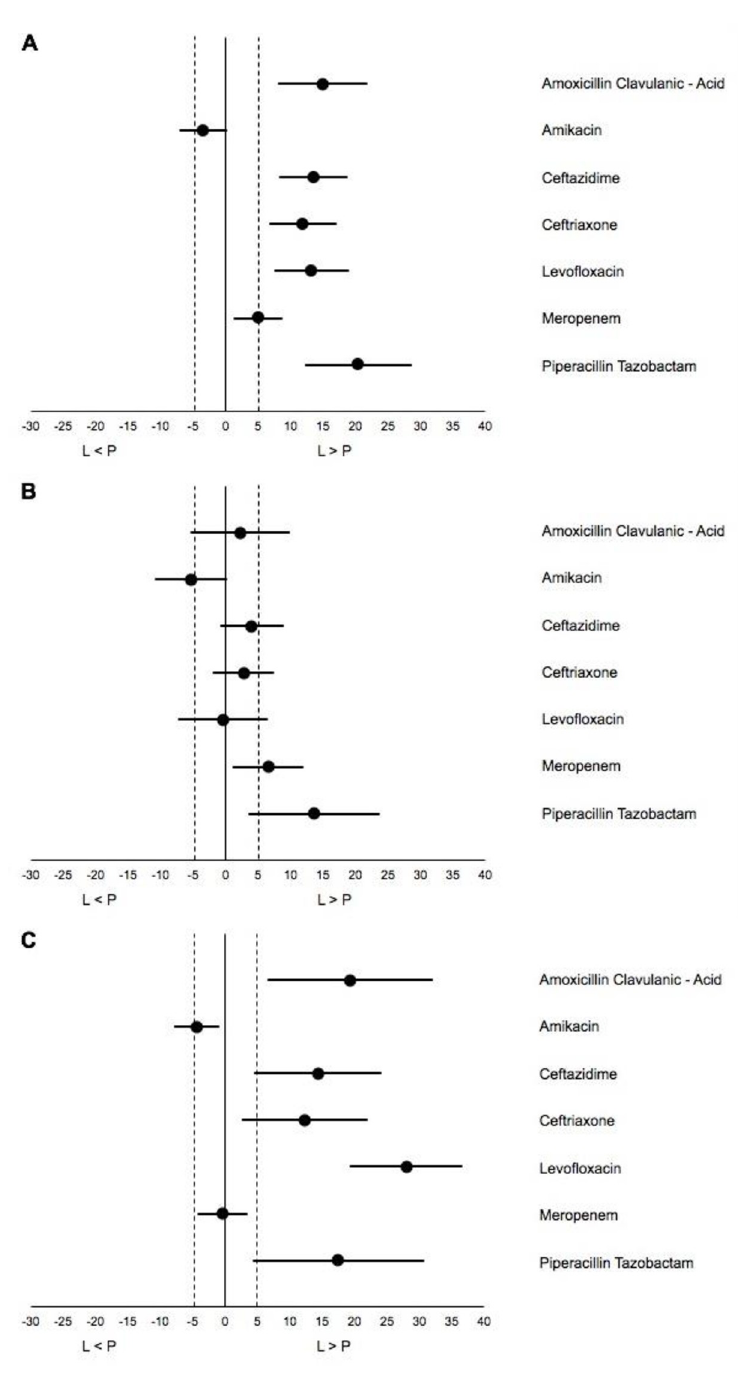
Fig 1. Difference in prevalence estimates between laboratory- and population-based surveillance. (A) Total (inpatient & outpatient setting) (B) Inpatients; (C) Outpatients; L > P = Laboratory-based surveillance prevalence estimate of resistance higher than population-based surveillance estimate. Bullets: percentage point difference between laboratory- and population-based surveillance. Horizontal lines: confidence interval for the difference.